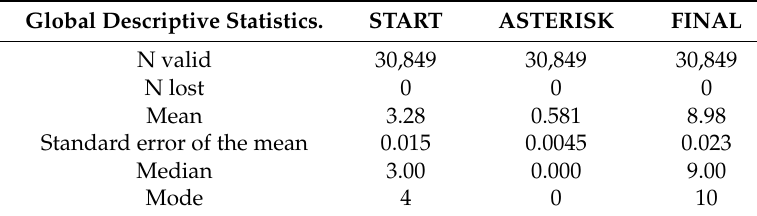
Table 1. Global descriptive statistics by start, asterisk, and final levels. Global Descriptive